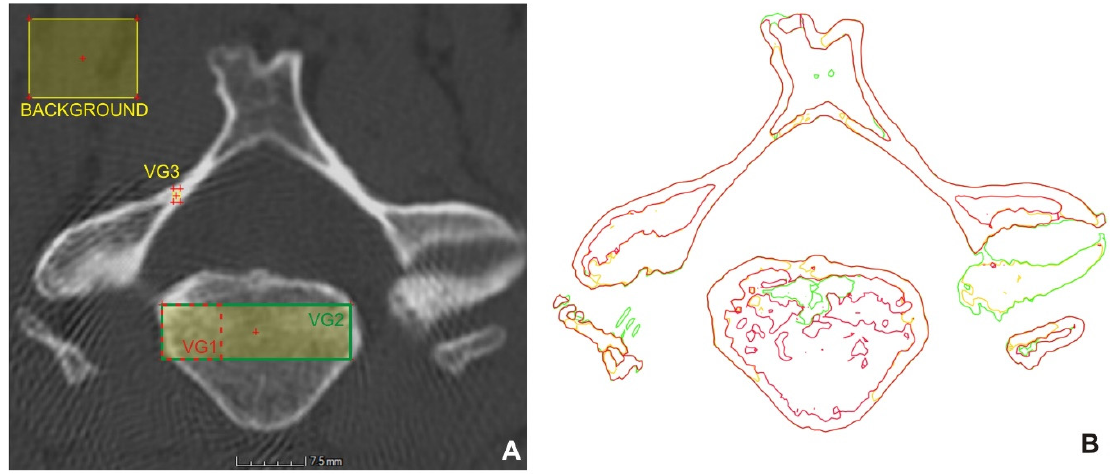
Figure 2. Areas for surface determination ( A ), obtained surfaces ( B ).